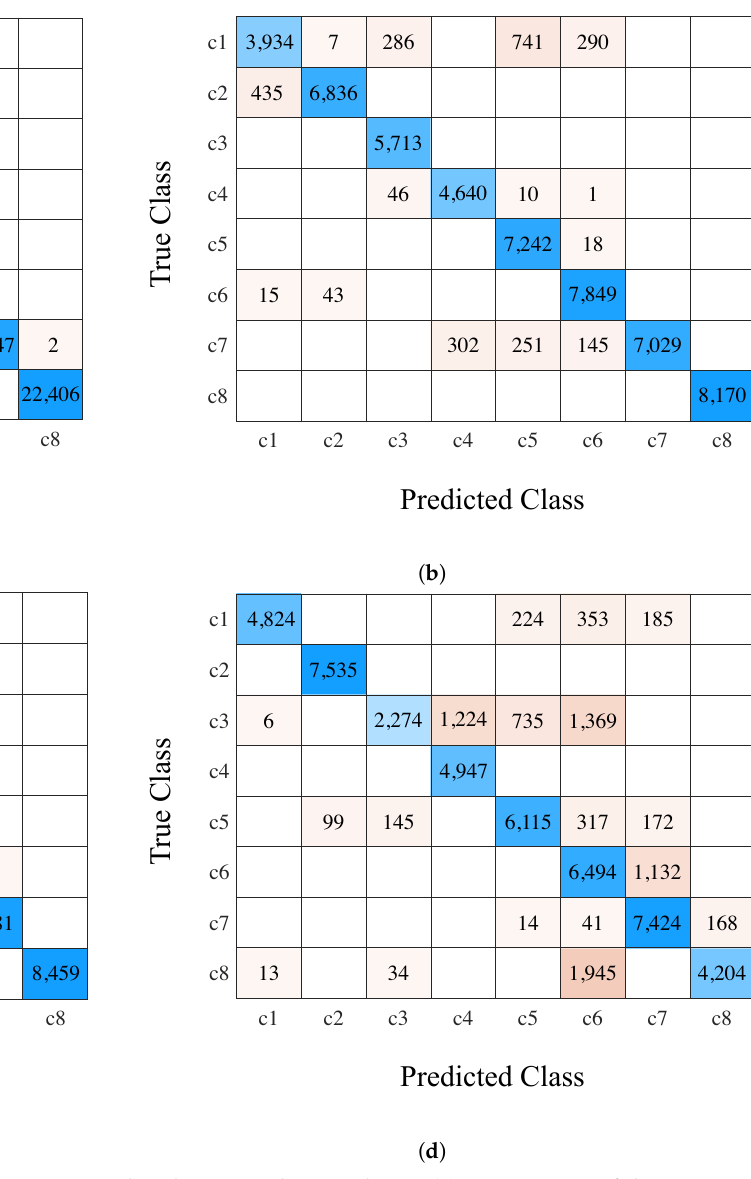
Figure 9. Confusion matrix trained and untrained smartphone. ( a ) Aggregation of three trained smartphones (accuracy: 99.80%); ( b ) Samsung Galaxy S20 (accuracy: 95.20%); ( c ) Samsung Galaxy S9 (accuracy: 88.23%); ( d ) OnePlus 7T Pro (accuracy: